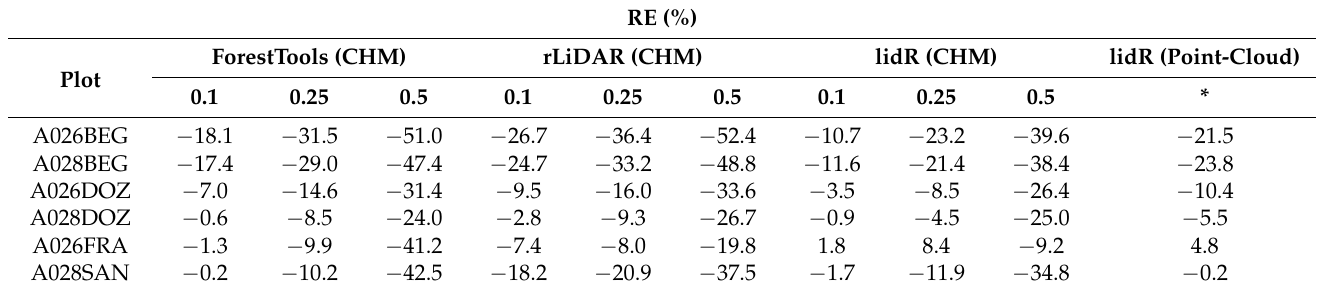
Table 3. Relative error (RE in %) of the different combinations of algorithms/plot/species/CHM resolution (ForestTools, lidR CHM-based, rLiDAR, and lidR point cloud-based, are the different algorithms evaluated. 0.1; 0.25 and 0.5 are the different resolutions (in m) of the CHM. A026 and A028 indicate plots occupied by Pinus pinaster or Pinus radiata , respectively). A negative RE value indicates that the number of trees detected is being underestimated.